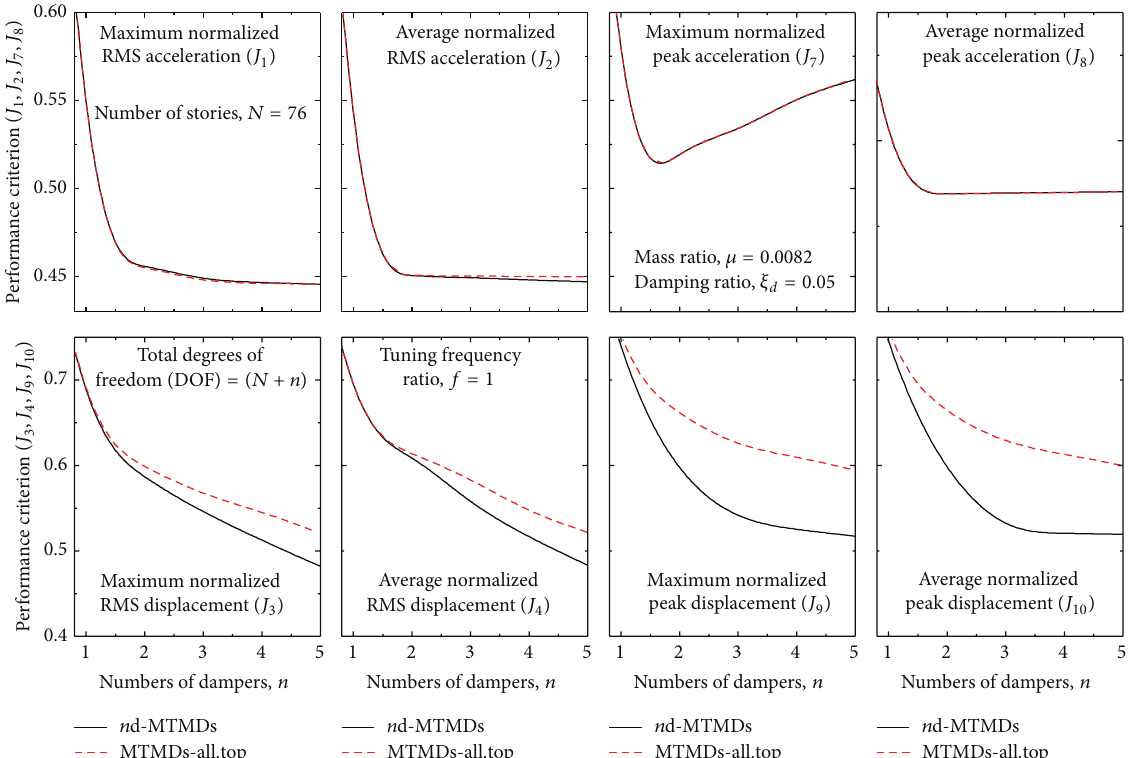
Figure 6: Variation of performance criteria 𝐽 1 to 𝐽 4 and 𝐽 7 to 𝐽 10 with number of d-MTMDs and MTMDs.